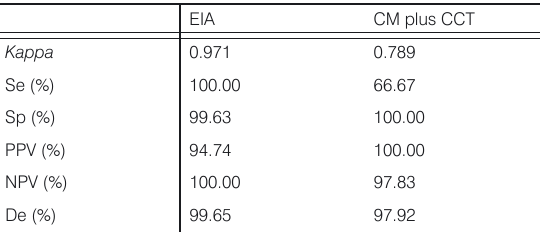
Table 5. Diagnostic characteristics of EIA and CM plus CCT of the first sample.